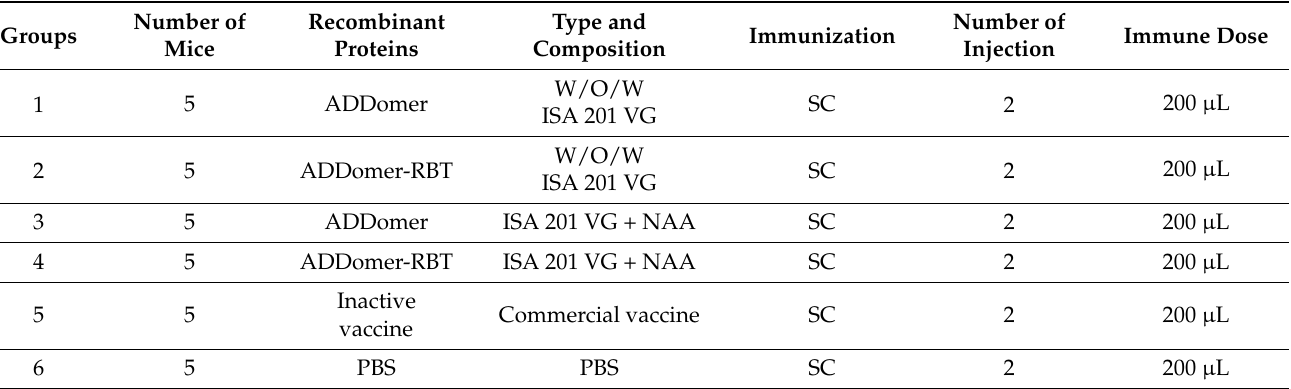
Table 2. Design of animal